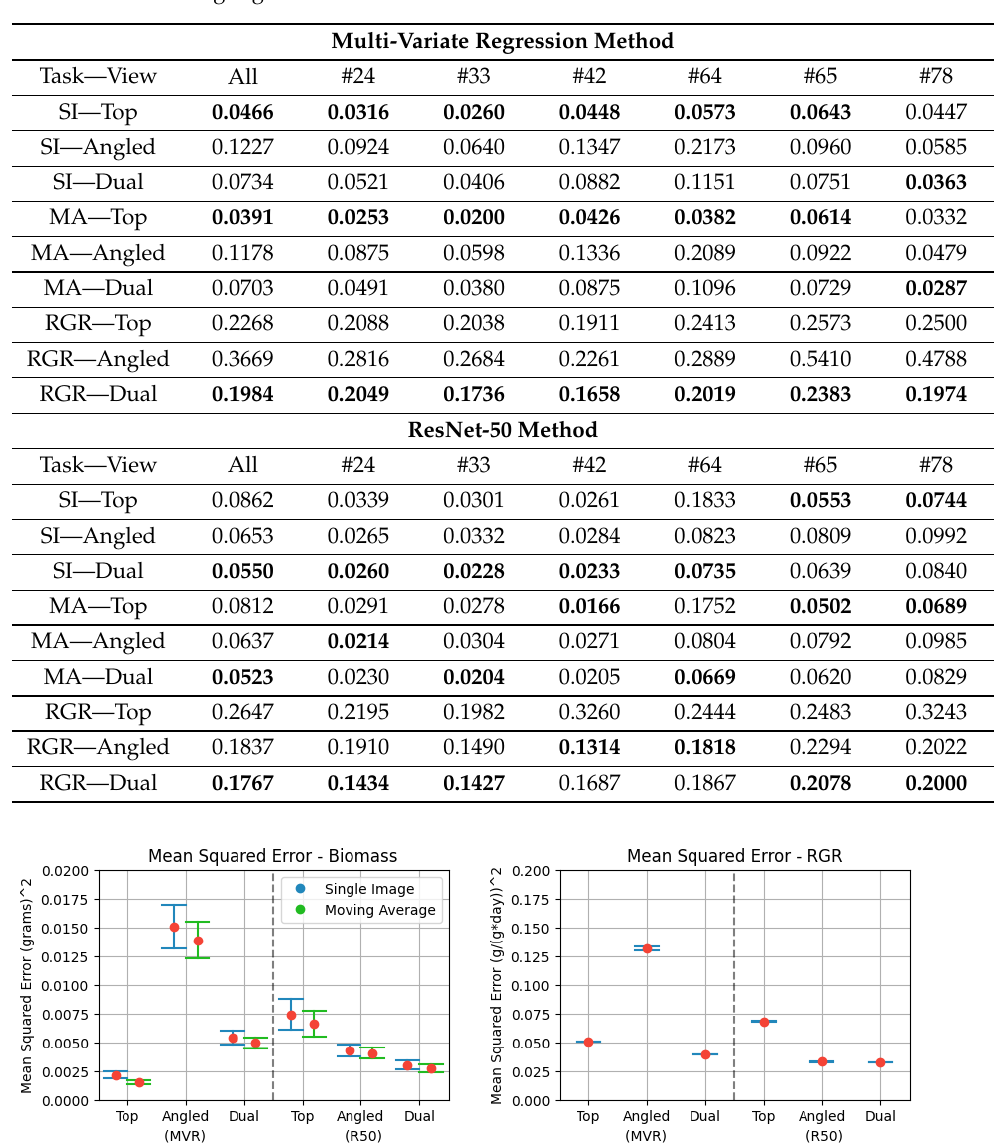
Table 3. RMSE on test set as a whole and a few, randomly picked, individual plants from the MVR network (above) and R-50 based network (below). Results are presented for all tasks: SI = Single Image, MA = Moving Average, RGR = Relative Growth Rate. The best method for a given task for each individual is highlighted in bold.